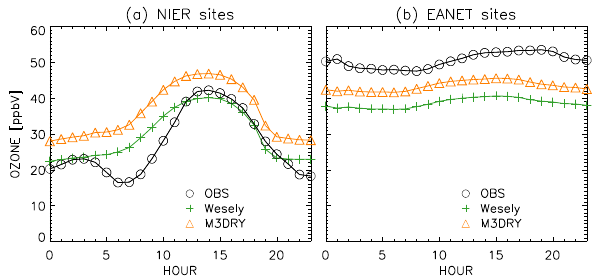
Figure 4. Hourly mean O 3 concentrations averaged over (a) the NIER sites (left) and (b) EANET sites (right) for May 2004. The simulated values were sampled from the model grids that corre- spond to the site locations. The observations are denoted with open circles, and the simulated values with the Wesely and the M3DRY are shown using plus signs and triangles,